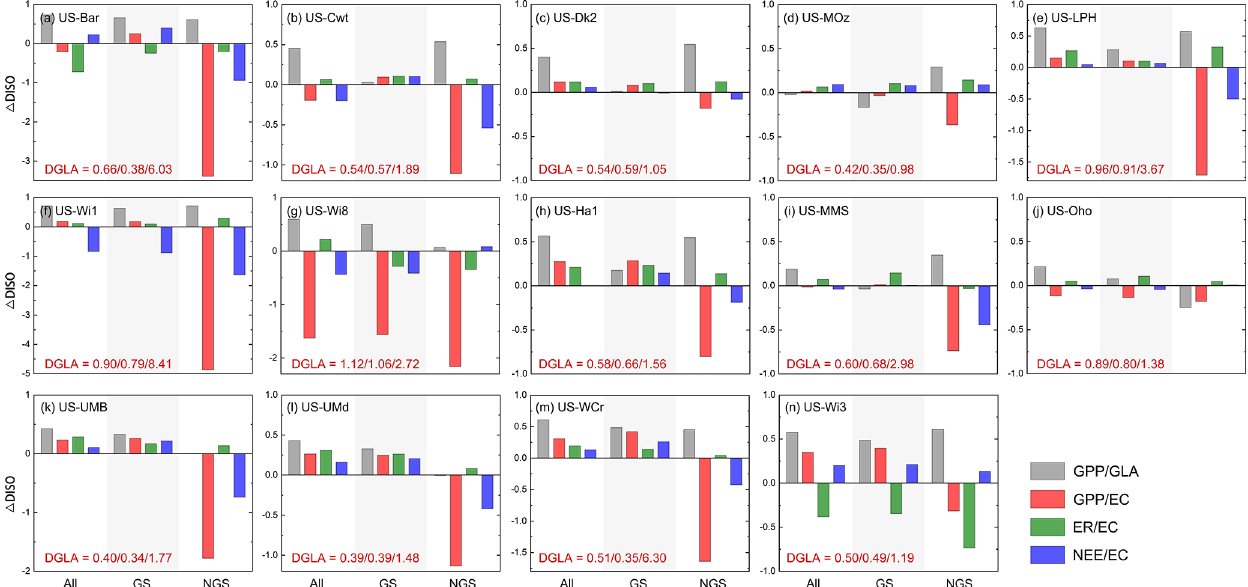
Figure 10. Optimized carbon fluxes performances for 14 flux sites throughout the whole year (All), growing season (GS, May to Septem- ber), and non-growing season periods (NGS). The y axis means the changes between the DISO indexes before and after the optimization: (cid:49) DISO =− (DISO Opt − DISO Def ) / DISO Def . Positive values represent improvement. The gray bars (GPP/GLA) represent the DISO index between the modeled GPP and the GLASS GPP products, while the red (GPP/EC), green (ER/EC), and blue (NEE/EC) bars mean the DISO index between the modeled fluxes (GPP, ER, and NEE) and the observed values at each flux site, respectively. EC represents the flux obser- vations. The bottom left of each pattern shows the DISO index between the GLASS GPP product and the observations (DGLA) throughout three periods (All, GS and NGS).